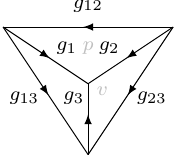
Figure 7 . A vertex v and a neighbouring triangle p